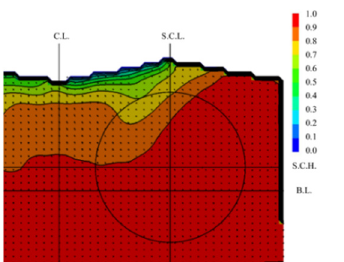
Figure 15. Comparison of results of the wake distribution of KCS. ( Left : EFD, Center : k -omega SST, Right : LPST).